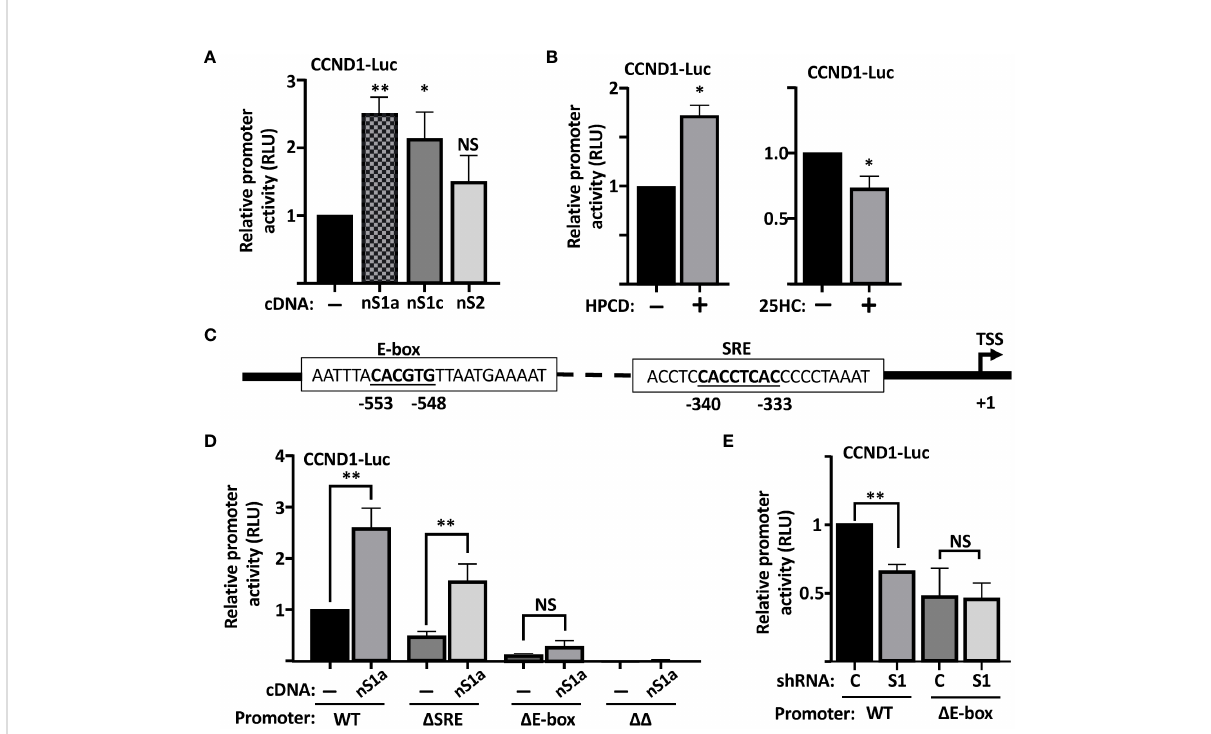
FIGURE 3 The human cyclin D1 promoter is SREBP-responsive. (A) HEK293 cells were transfected with the CCND1-luc promoter-reporter gene ( CCND1- Luc ) together with either empty vector ( pcDNA3 ) or expression vectors for the nuclear forms of SREBP1a ( nS1a ), SREBP1c ( nS1c ), or SREBP2 ( nS2 ). Forty-eight hours after transfection, cells were lysed, and luciferase activity was measured. (B) HepG2 cells were transfected with the CCND1-luc promoter-reporter gene and treated as indicated. Cells in regular media were either left untreated or treated with 1% HPCD (w/v) for 4 h ( left ). Cells in LPDS were either left untreated or treated with 25HC (5 m g/ml) for 8 h ( right ). Forty-eight hours after transfection, cells were lysed, and luciferase activity was measured. (C) Schematic illustration of the human cyclin D1 promoter with the location of the E-box and putative SRE elements. (D) HepG2 cells were transfected with the CCND1-luc promoter – reporter gene, either wild type ( WT ) or the indicated deletion mutant ( D SRE , D E-box or DD ) together with either empty vector ( pcDNA3 ) or an expression vector for the nuclear form of SREBP1a ( nS1a ). Forty-eight hours after transfection, cells were lysed, and luciferase activity was measured. (E) HepG2 cells were transfected with the CCND1-luc promoter – reporter gene, either wild type ( WT ) or the D E-box mutant, together with expression vectors for either non-targeted (C) or SREBP1-targeted ( S1 ) shRNA. Forty-eight hours after transfection, cells were lysed, and luciferase activity was measured. Signi fi cance was determined by paired t-tests (B, D, E) or one-way ANOVA with Tukey ’ s multiple comparisons adjustment (A) . p-values lower than 0.05